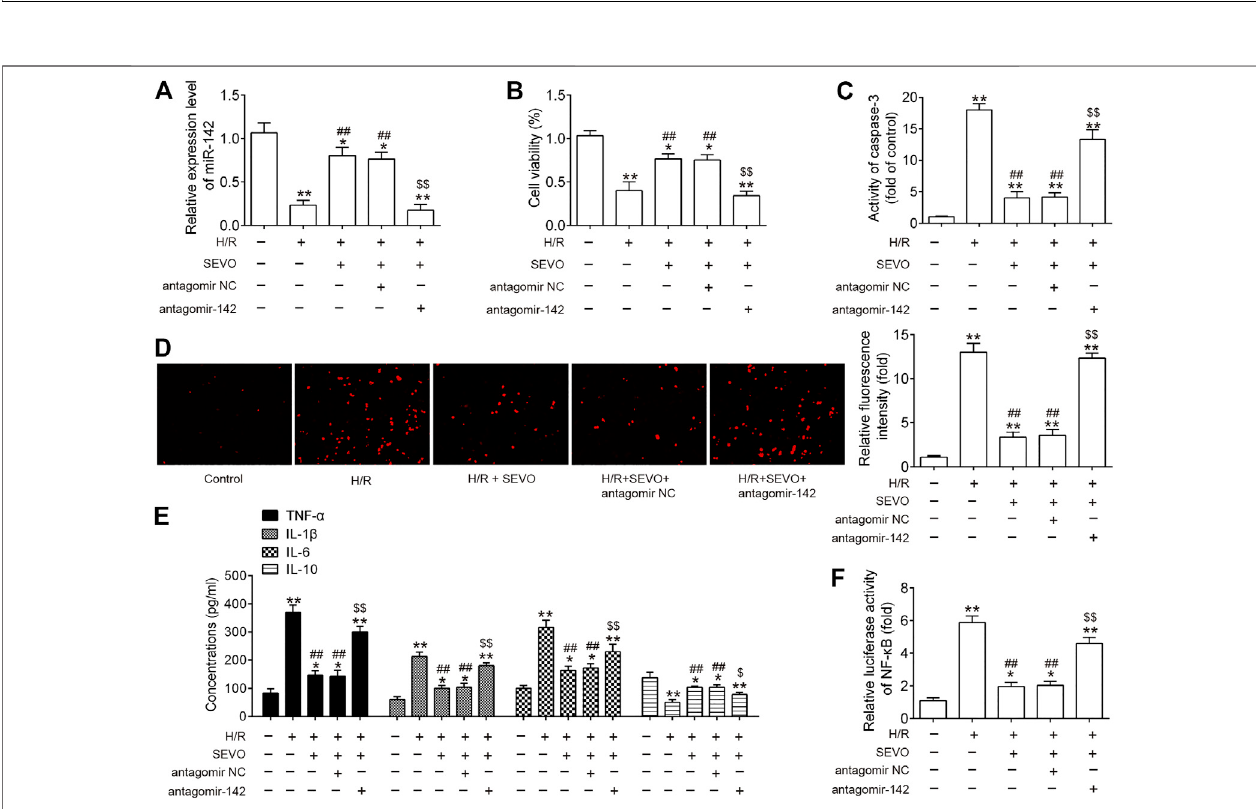
FIGURE 8 | Sevo postconditioning exerts its protective effect against hepatic I/R injury through inhibiting the TLR4/MyD88/NF- κ B signaling pathway in vitro. Cells were transfected with antagomir-NC/antagomir-142 (100 nM) for 24 h, and then subjected to H/R for 6 h. Before hypoxia treatment, cells were placed in a semi-airtight container and 2% sevo fl urane was used for 2 h of pre-treatment. (A) The expression levels of miR-142 was measured by qRT-PCR. (B) Cell viability was determined by CCK-8 assay. (C) The activity of caspase-3 was measured by a commercial kit. (D) ROS production was assessed by DCFH-DA assay. (E) The in fl ammatory and anti-in fl ammatory cytokines including TNF- α , IL-1 β , IL-6, and IL-10, were evaluated by ELISA assays. (F) Luciferase activity of NF- κ B was quanti fi ed using the Promega luciferase assay kit on a luminometer. All data were measurement data which were expressed as mean ± standard deviation and analyzed by one-way analysis of variance. * p < 0.05, ** p < 0.01 vs. Control group; # p < 0.05, ## p < 0.01 vs. H/R group; $ p < 0.05, $$ p < 0.01 vs. H/R + Sevo + antagomir NC group.